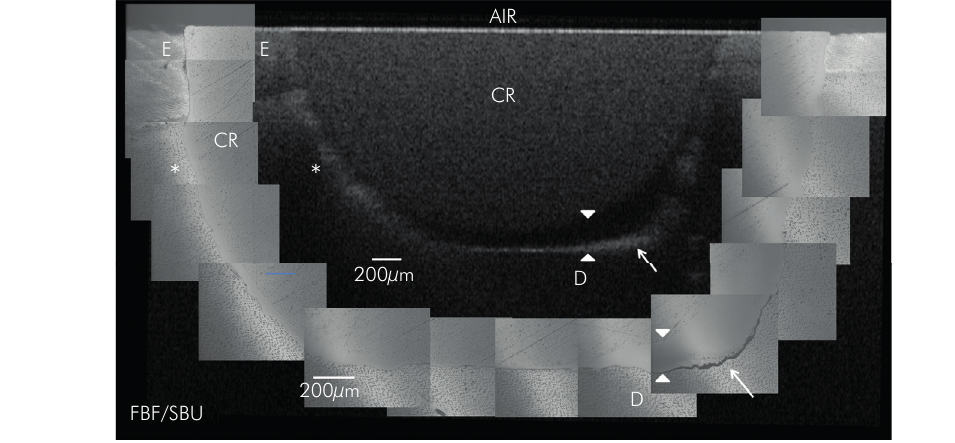
Figure 7. Representative 2D OCT image of FBF/SBU and its corresponding CLSM image. Interfacial gaps, which exhibited higher brighter pixels in the OCT images, were confirmed by CLSM as pointed by the arrows. The asterisk shows interfacial areas with bright pixels, however they are not considered as gap. It most probably indicates areas with adhesive penetration. Arrow heads are pointed toward the adhesive layer, corresponding to 90 µm in CLSM images.